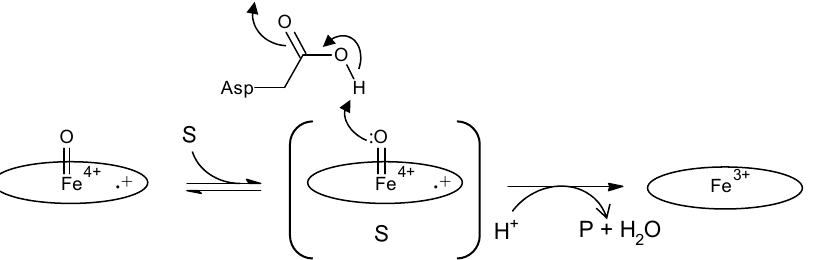
Figure 3. Schematic diagram of two-electron oxidation of substrates by a DyP-type peroxidase, proposed in [20]. Left, compound I; center, ES complex; right, resting state. Oval denotes the heme plane in the enzyme. Asp is the catalytic residue. S and P denote substrate and product, respectively. In a general peroxidase, compound I changes to compound II with one electron reduction, as shown in Figure 2, but in this scheme, compound I of DyP-type peroxidases changes to the resting state directly through two-electron reduction.